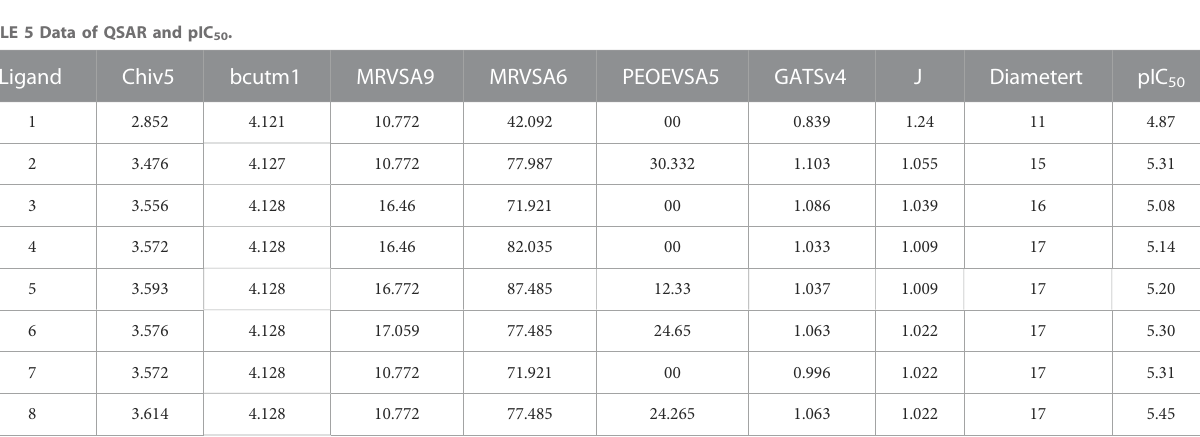
TABLE 5 Data of QSAR and pIC 50